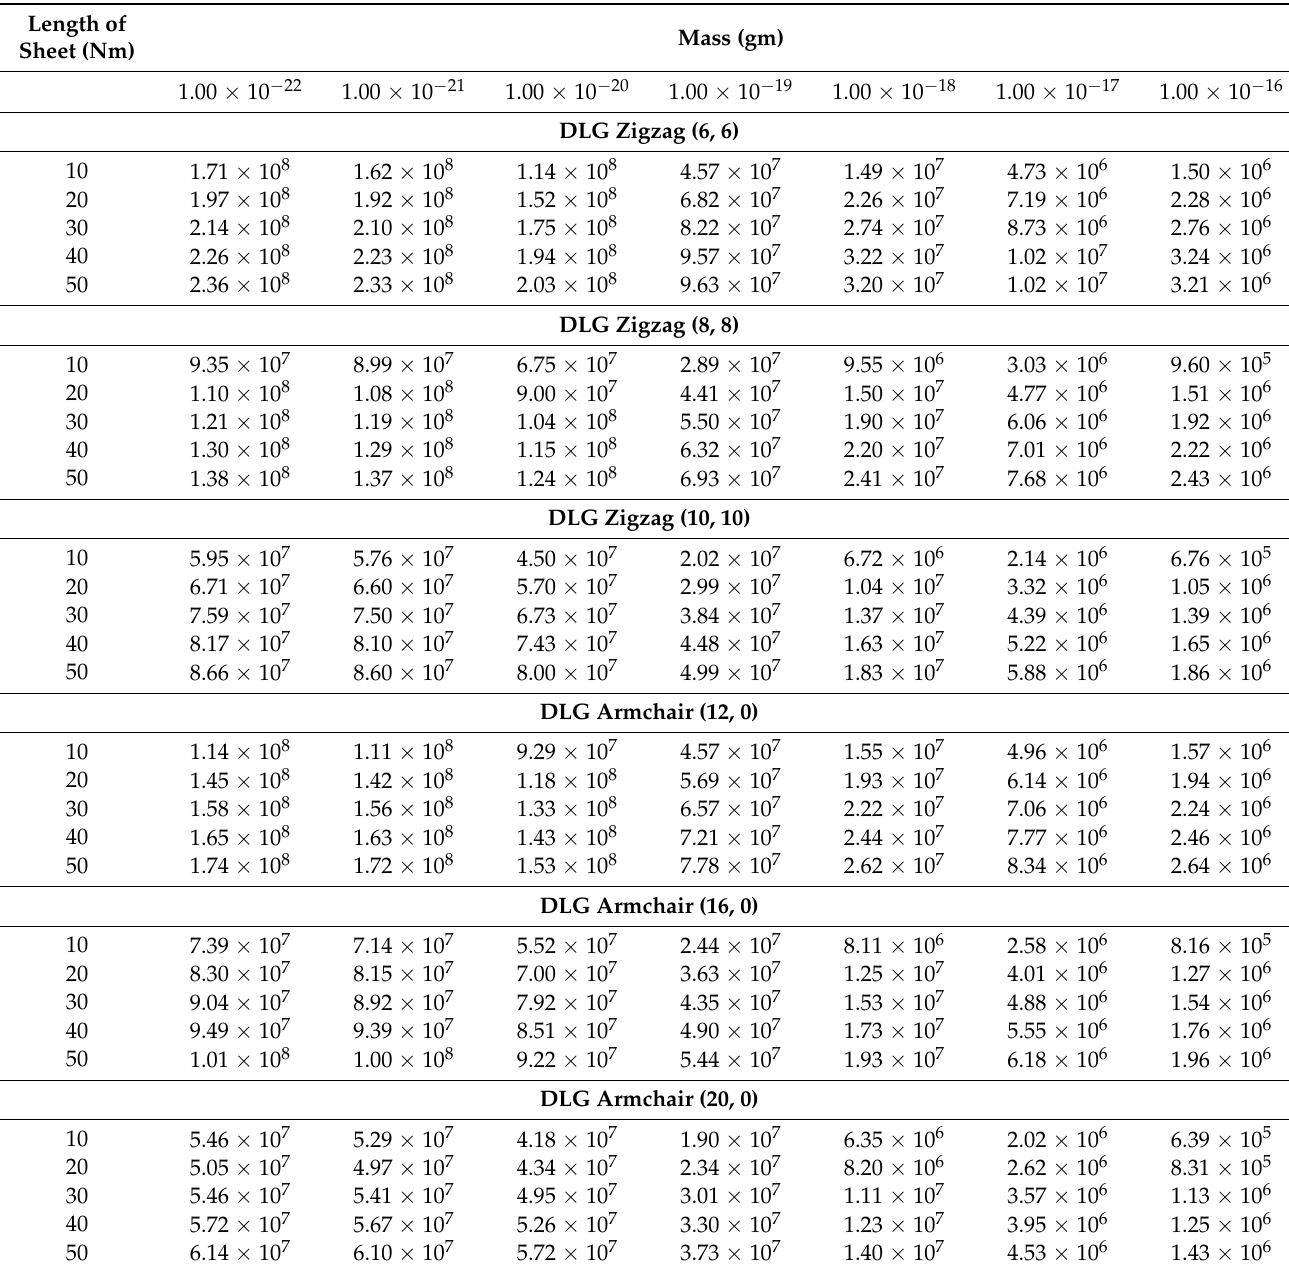
Table 2. Cantilever zigzag and armchair DLG with mass addition at tip of